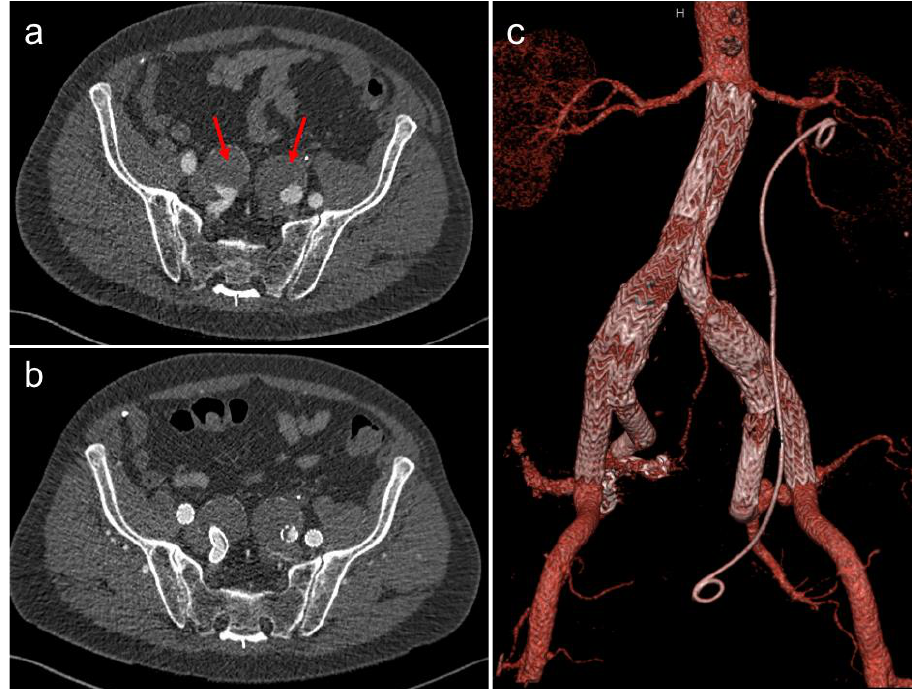
Figure 6. ( a ) CT angiogram showing bilateral internal iliac artery aneurysms (red arrows). The patient underwent EVAR with bilateral iliac branch devices (IBD). ( b ) Follow-up CT post-repair. ( c ) Volume-rendered image of the same post-operative CT showing the EVAR and bilateral IBD. Note the incidental left ureteric stent.